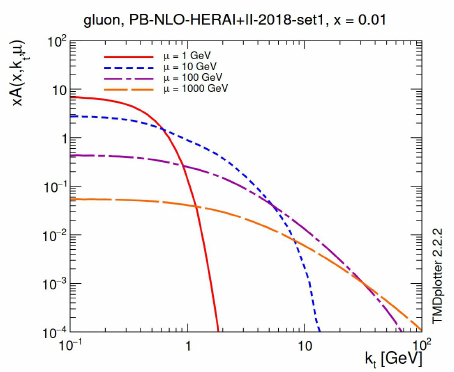
Figure 1 . TMD gluon distributions versus k T for momentum fraction x = 10 − 2 and different values of the evolution scale µ . The PB TMD Set 1 of ref. [52] is